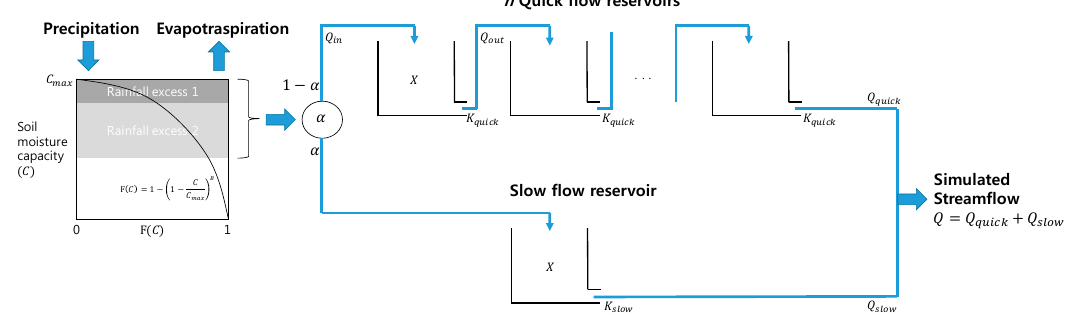
Figure 3. Schematic description of the modified hydrological model (HYMOD).